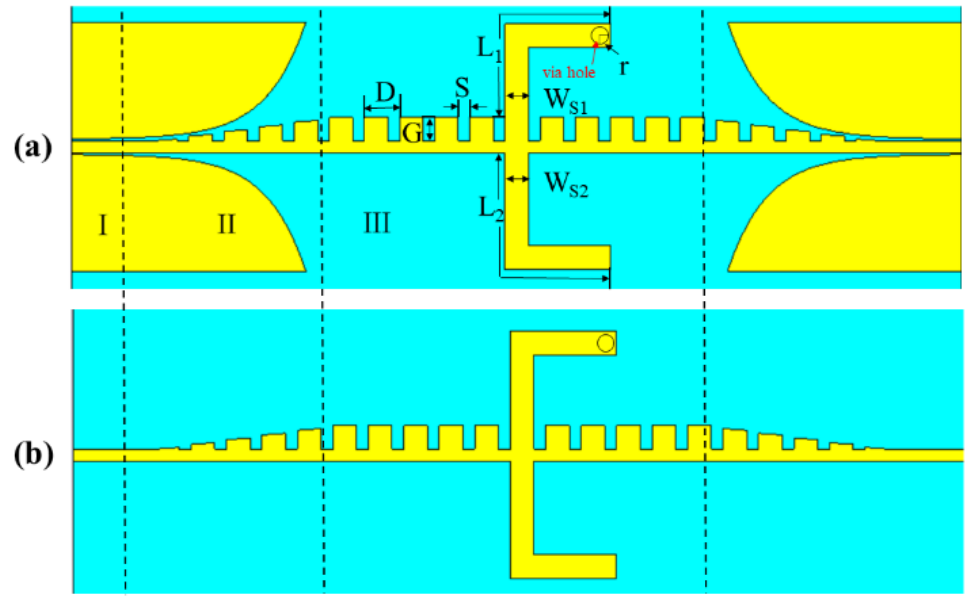
Figure 6. Schematic of the broadband bandpass filter with a single combined-stub dual-mode resonator. ( a ) Up-layer schematic of the filter. ( b ) Down-layer schematic of the filter.